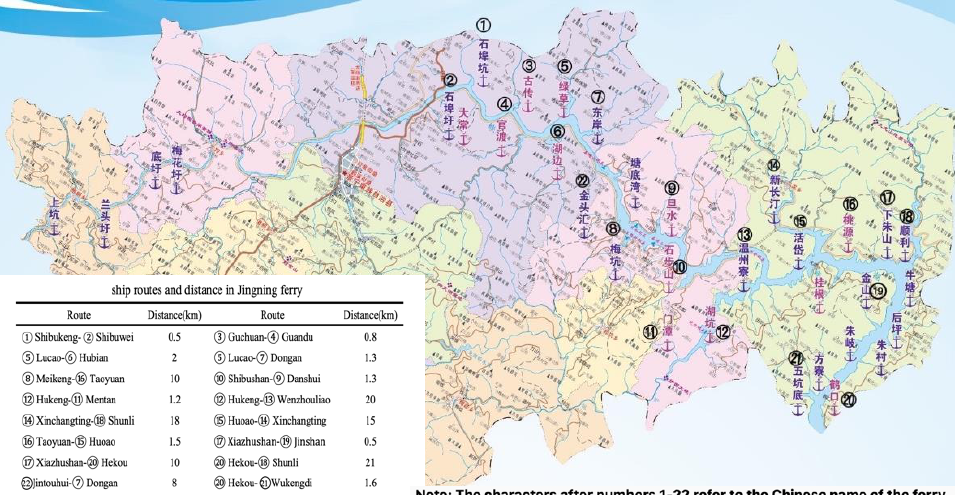
Figure 1. Jingning county ferry distribution map. Table 2. The 2021 ferryboat carbon emissions